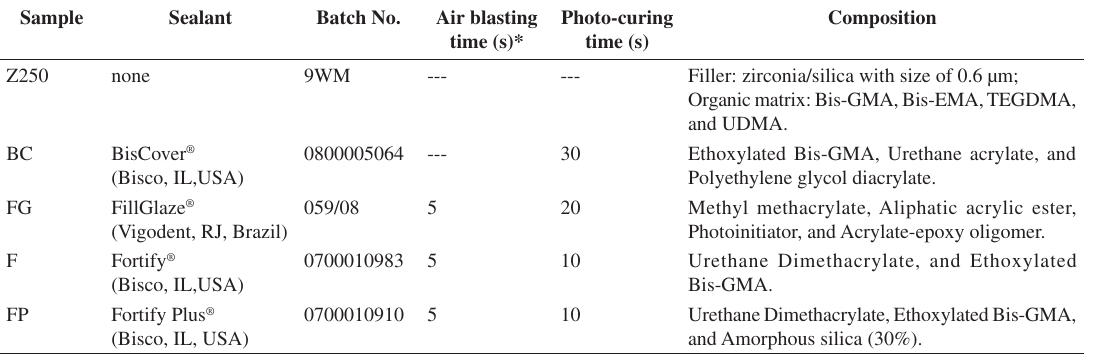
Table 1. Summary of the materials data and procedures for applying the surface sealers on the Filtek Z250 ® composite resin samples (according to the instructions of the manufacturers). Sample Sealant Batch No. --- --- Filler: zirconia/silica with size of 0.6 µm; Organic matrix: Bis-GMA, Bis-EMA, TEGDMA, and